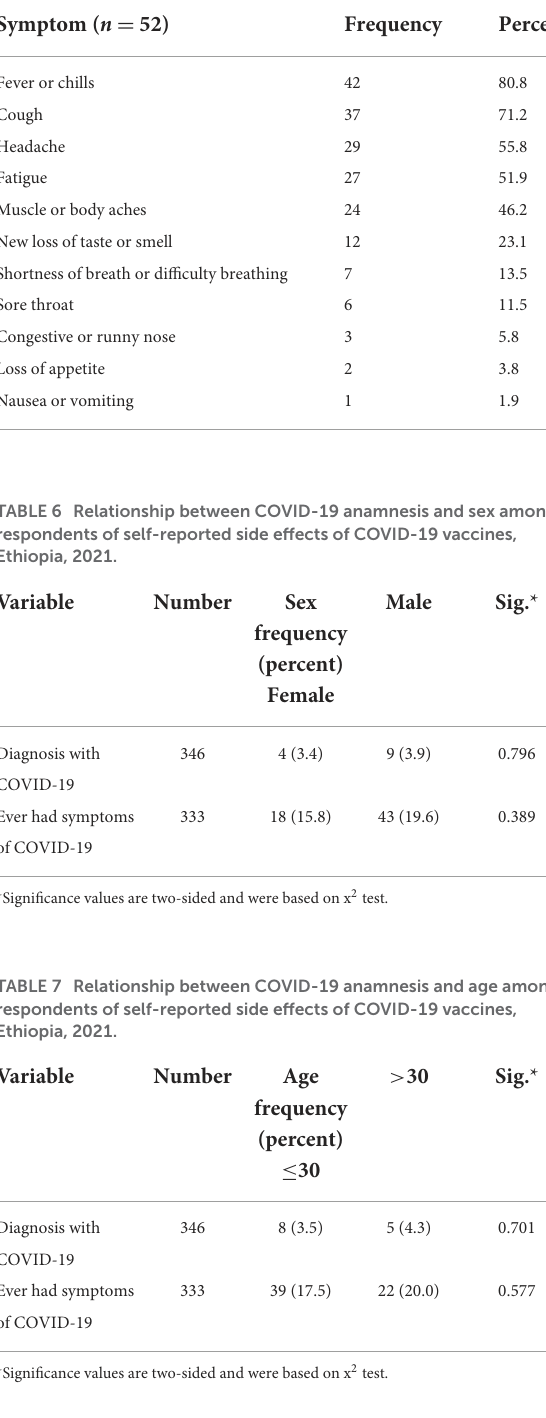
TABLE 5 Distribution of COVID-19 like symptoms among the respondents who reported COVID-19 like symptoms of respondents of side effects of COVID-19 vaccine, Ethiopia, 2021.